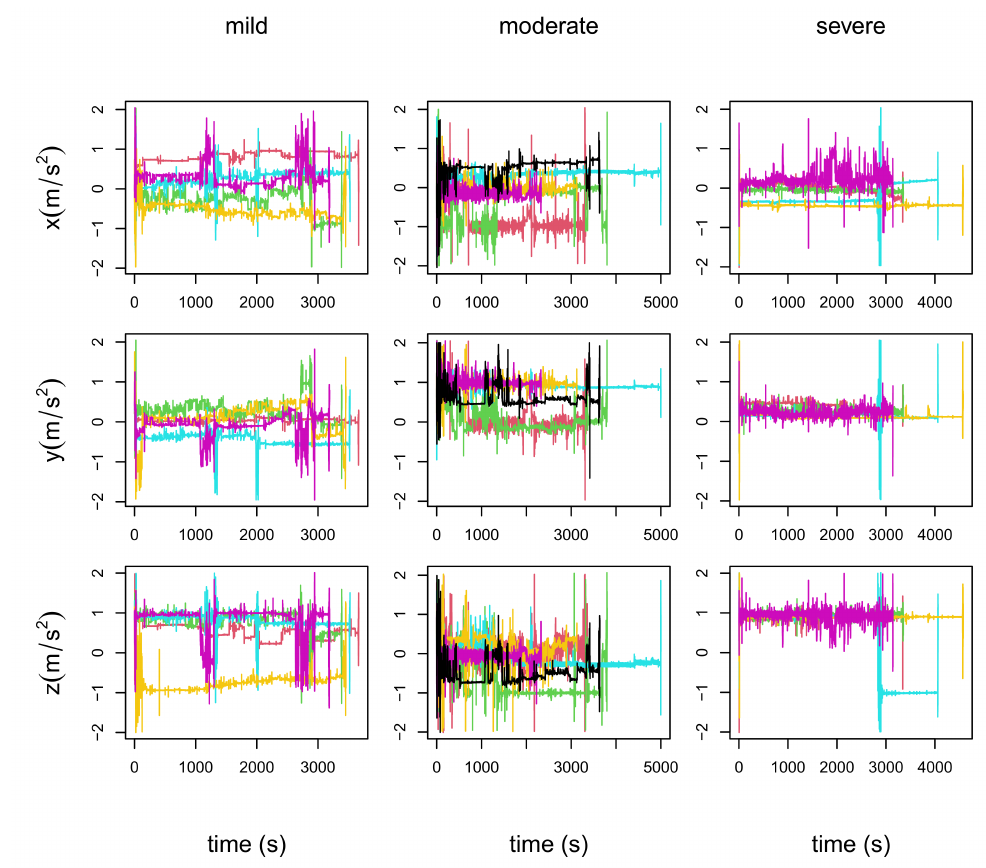
Figure 4. Display of the accelerations (m/s 2 ), in the three coordinate axis (OX: top row, OY: central row and OZ: bottom row) over the time domain (s), of the repetitions of three patients. Each patient is in a different stage of the disease. Left column: mild stage (patient 19). Central column: moderate stage (patient 34). Right column: severe stage (patient